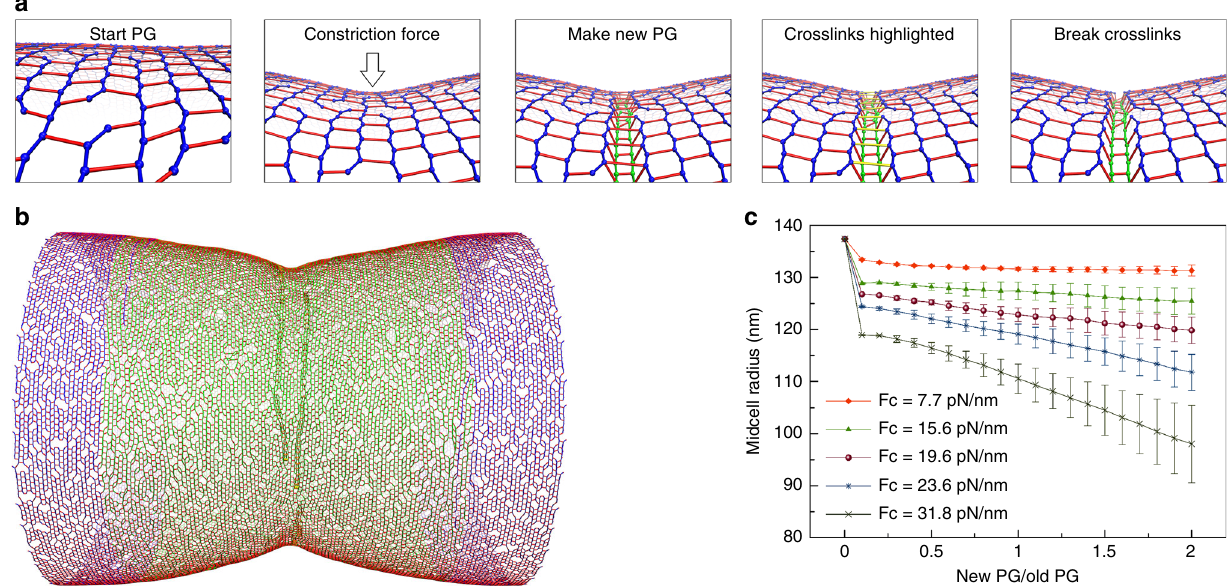
Fig. 6 Cell wall synthesis in the presence of both a constrictive force and the make-before-break mechanism. a Representative snapshots of a simulation sequence: the constriction force caused an initial constriction, and new peptidoglycan (PG) was made underneath the existing network in complete hoops before crosslinks (highlighted in yellow) above the new hoops were cleaved. b A snapshot of the sacculus showing that constriction occurred upon insertion of new PG when the force per circumference F c = 23.6pN/nm. c Pro fi les of the midcell radius with respect to the inserted amount of new PG. Each trace shows the average of four simulations. Error bars indicate standard deviation